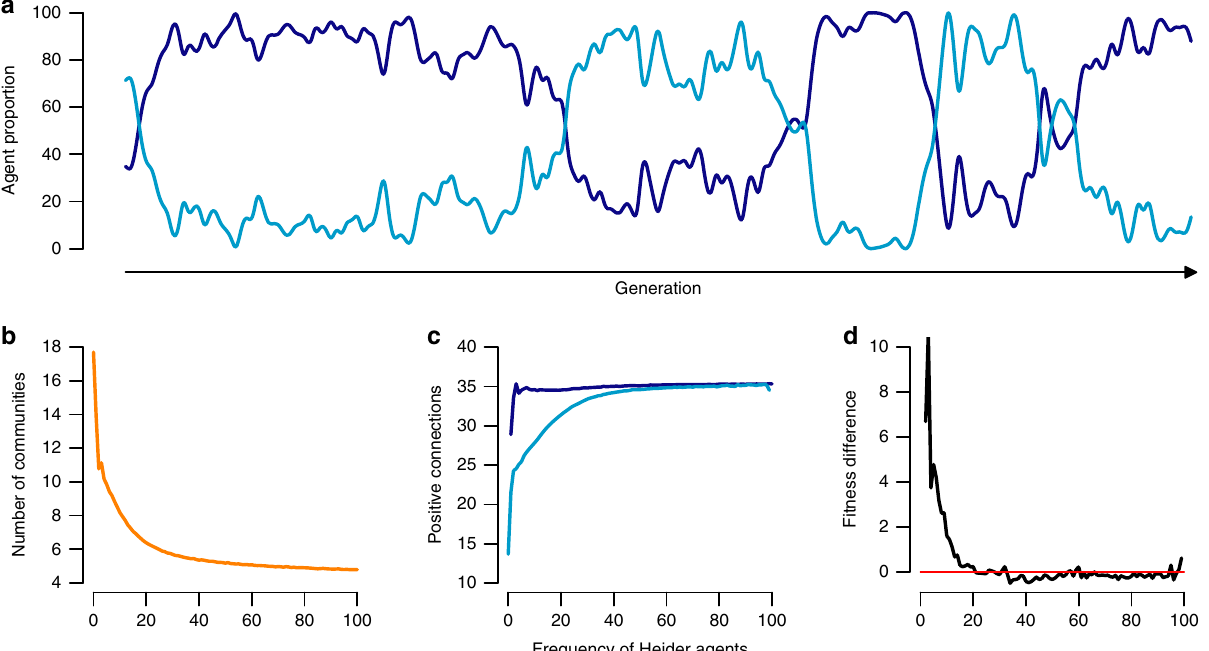
Fig. 5 Co-existence of Heider and friend-focused agents. Heider and friend-focused agents can co-exist and a population of Heider and friend-focused agents constantly transitions from one majority state to the other ( a ) — based on n = 100, 4 × 10 5 iterations, i = 10, c = 1, b = 4, r = 0.3. As observed in the simulations without mutations, the increase of Heider agents decreases the number of communities in the population ( b ). The ability of Heider agents (dark blue line) to make connections to isolated agents outside of their friendship-network initially leads to more (positive) outgoing connections compared to friend-focused agents (light blue line) ( c ). The difference in connectedness is accompanied by a fi tness advantage over friend-focused agents that diminishes, once the group structure is established (positive numbers indicate higher fi tness for Heider agents) ( d ) — based on n = 100, averaged over 5 × 10 7 iterations, i = 10, c = 1, b = 4, r = 0.3